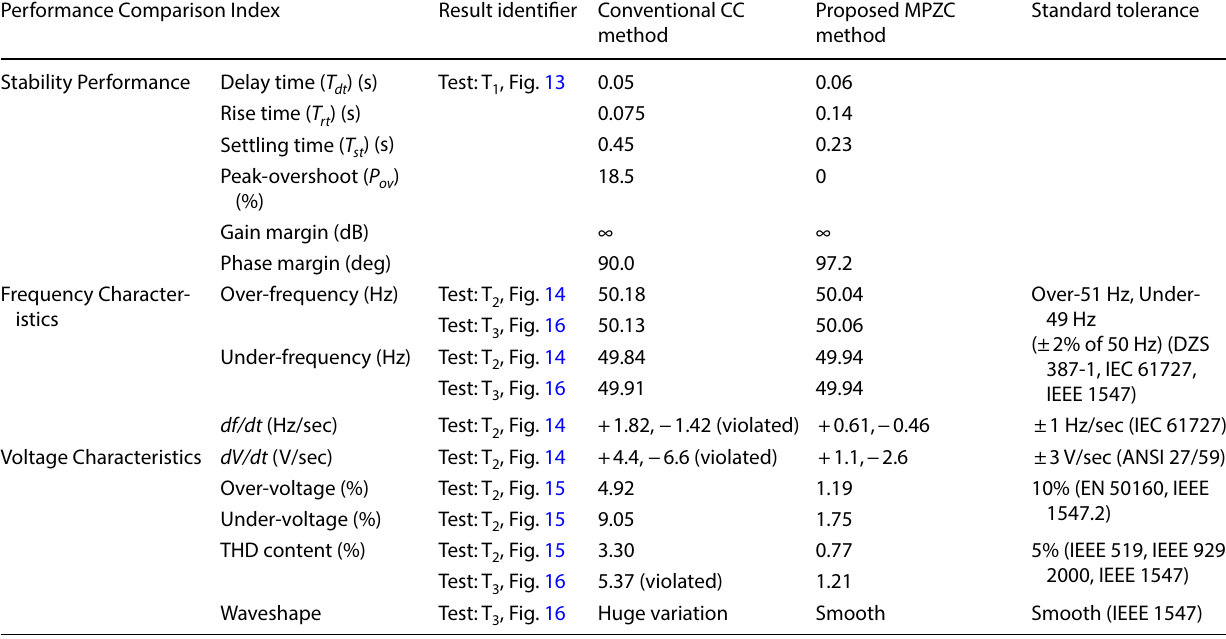
Table 11 Quantitative comparison of outcomes achieved with proposed and conventional methods